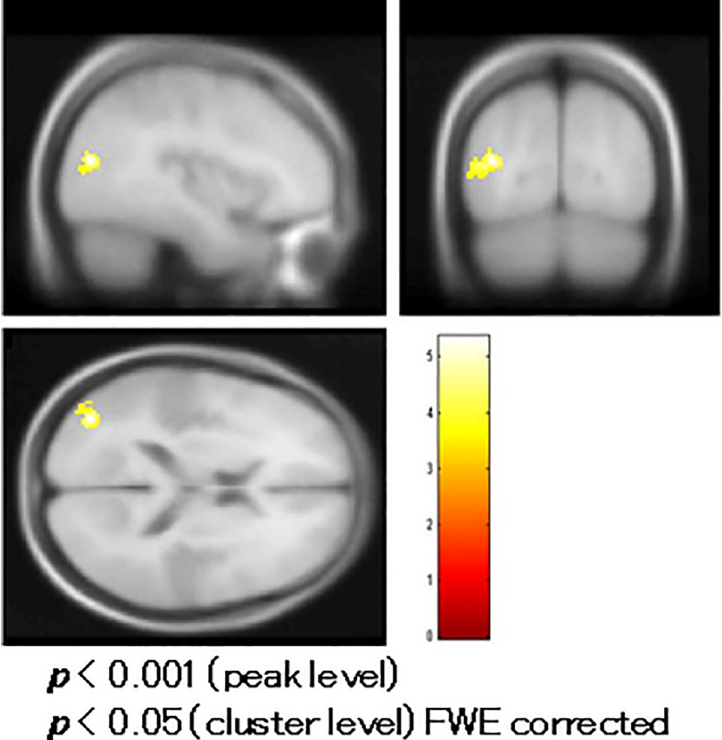
Fig 5. Comparison of functional magnetic resonance imaging (fMRI) between patients and controls. Patients with schizophrenia had reduced blood oxygenation level-dependent (BOLD) activity in the left middle temporal gyrus (Brodmann area/BA 39) compared to controls in a t-test with age and education as covariates.